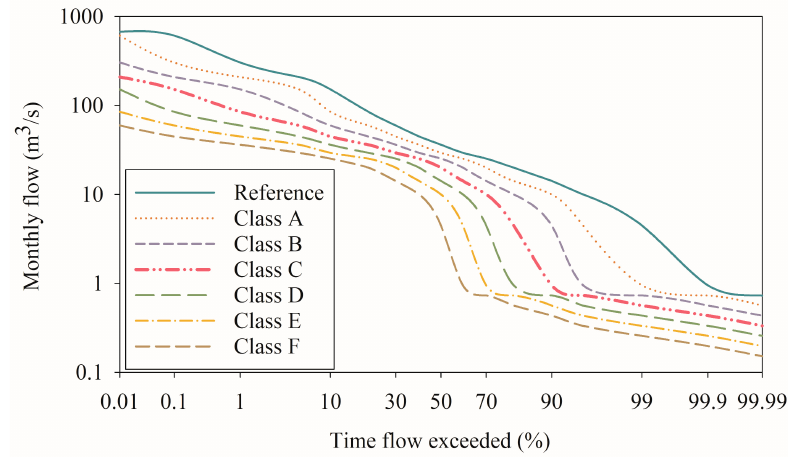
Figure 3. Flow duration curves for different environmental management classes using the flow duration curve (FDC) shifting method, the Kor River. Table 6. Estimation of Long-term EWR for different environmental management classes using the FDC shifting method, Kor River.